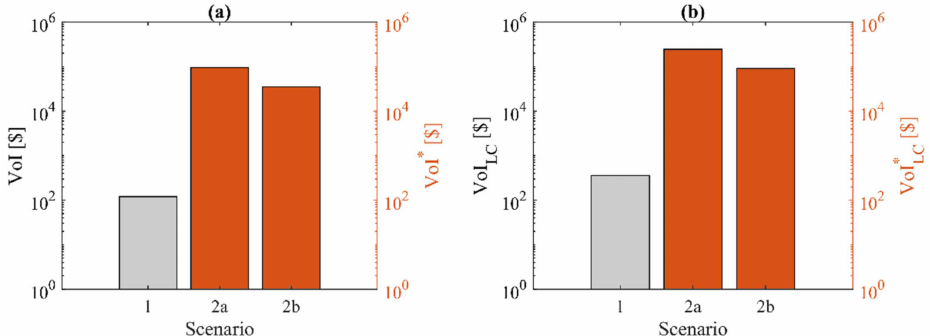
Figure 6. Post-earthquake emergency management: ( a ) VoI and ( b ) VoI LC for different decision scenarios (on a logarithmic